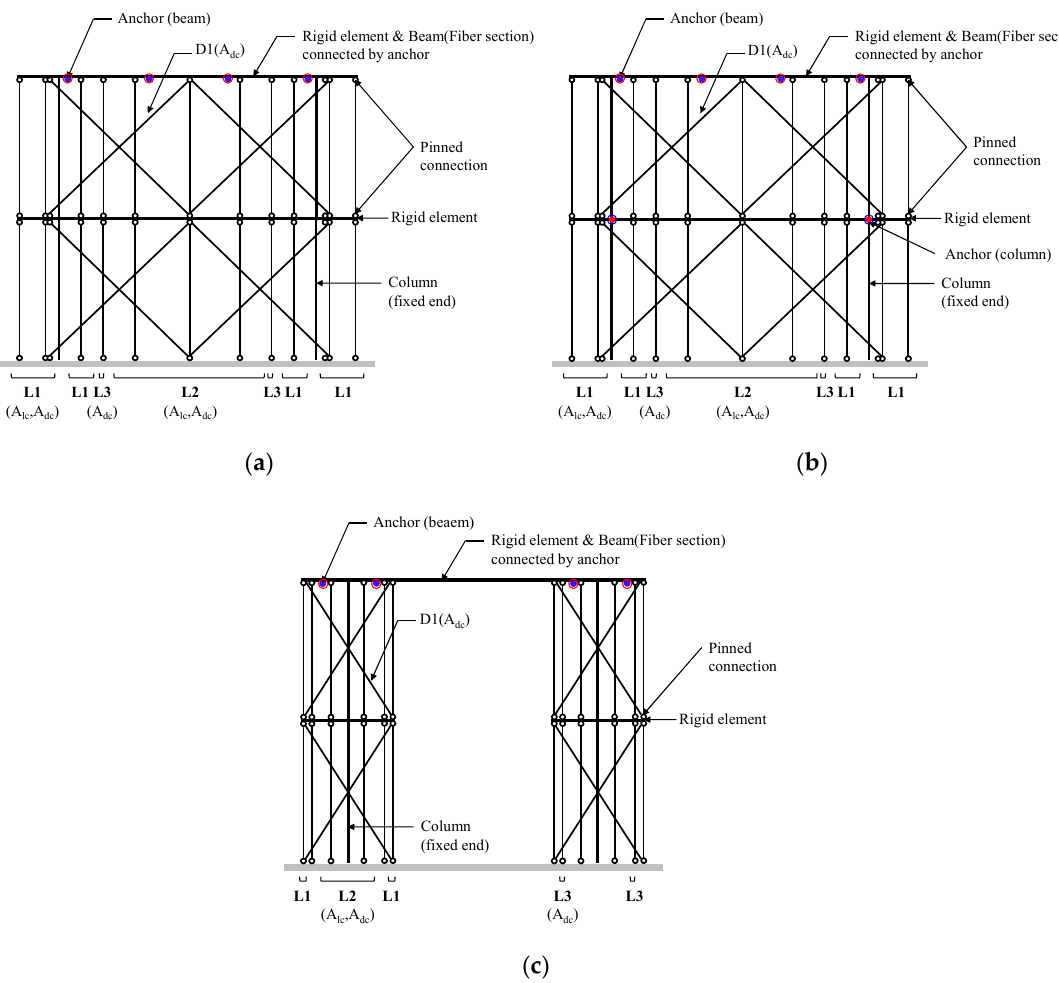
Figure 13. Idealized finite element model of externally anchored precast wall panel (EPCW): ( a ) Specimen FB; ( b ) Specimen FBC; ( c ) Specimen FPB. Table 1. Cross-section of each element for idealized analysis model.